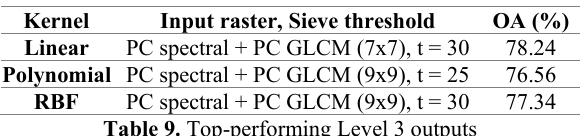
Table 9. Top-performing Level 3 outputs